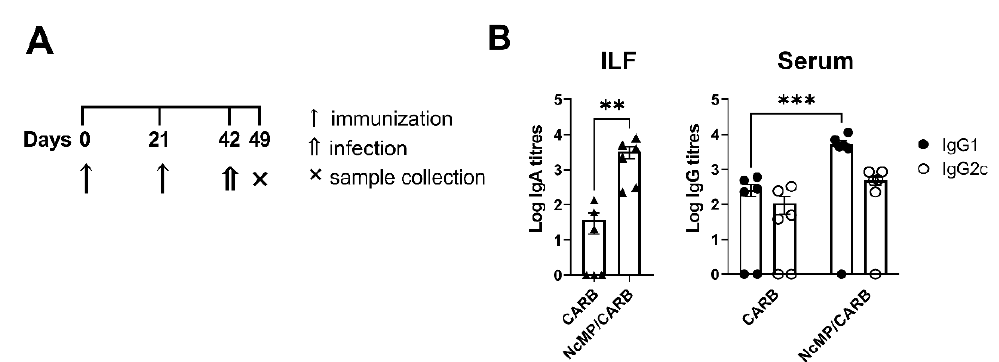
Figure 5. Analysis of N. caninum -specific antibodies in infected mice. Timeline of immunization, infection and sample collection ( A ). Titers of intestinal lavage fluid (ILF) IgA and serum (Serum) IgG1 and IgG2c ( B ), as indicated, were determined by ELISA in samples collected 7 days after N. caninum i.p. infection from mice previously immunized (NcMP/CARB) or sham-immunized (CARB). Data is presented as log 10 of the antibody titers. Each symbol (triangles and circles) represents an individual mouse. Bars correspond to the mean value in each group ± SEM. Results are of one representative experiment out of two independent experiments that yielded concordant results. ( n = 6 group; ** p < 0.01; *** p < 0.001, Mann – Whitney.)